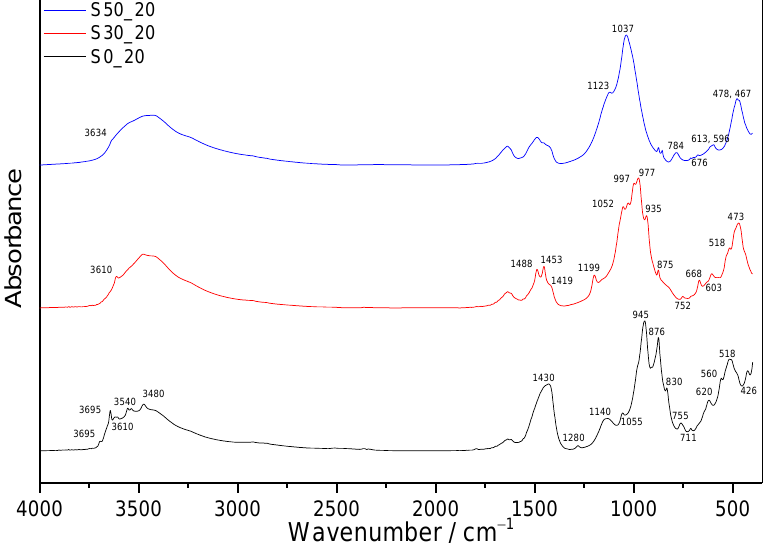
Figure 2. MIR spectra of samples hydrothermally treated at 2.0 MPa and 220 °C.